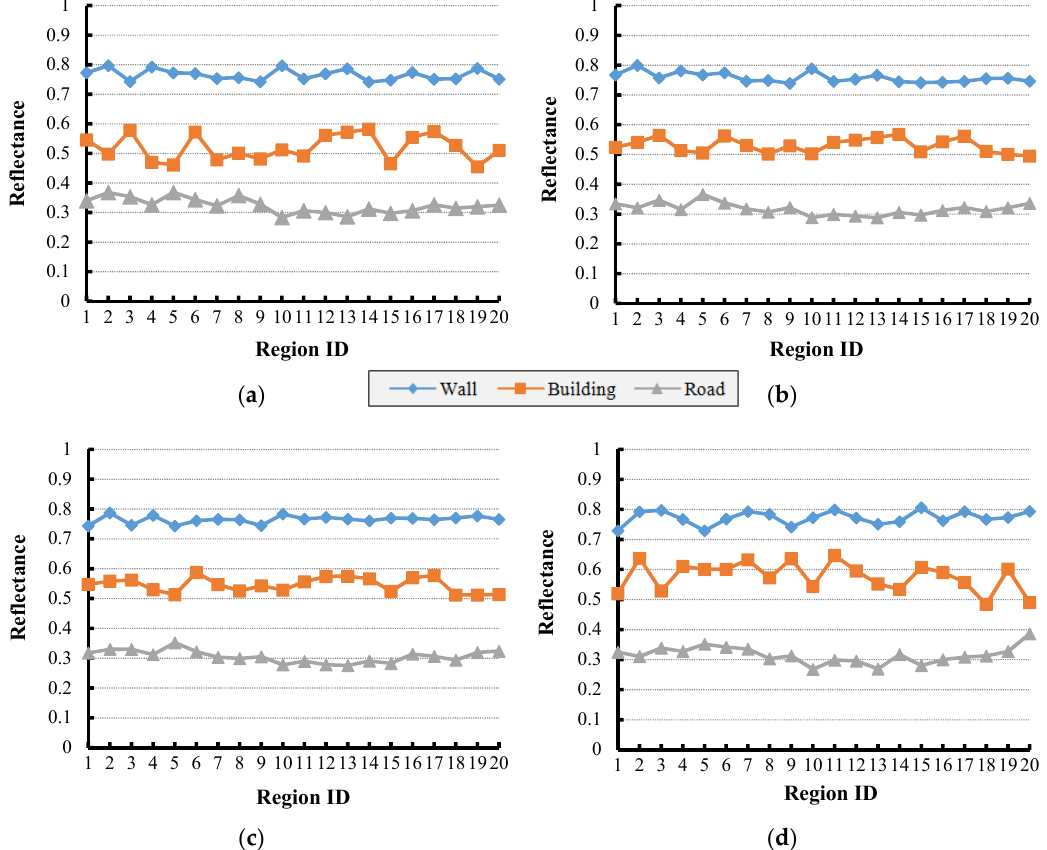
Figure 9. Absolutely corrected intensity values of the sampled regions of the three surfaces. ( a ) The